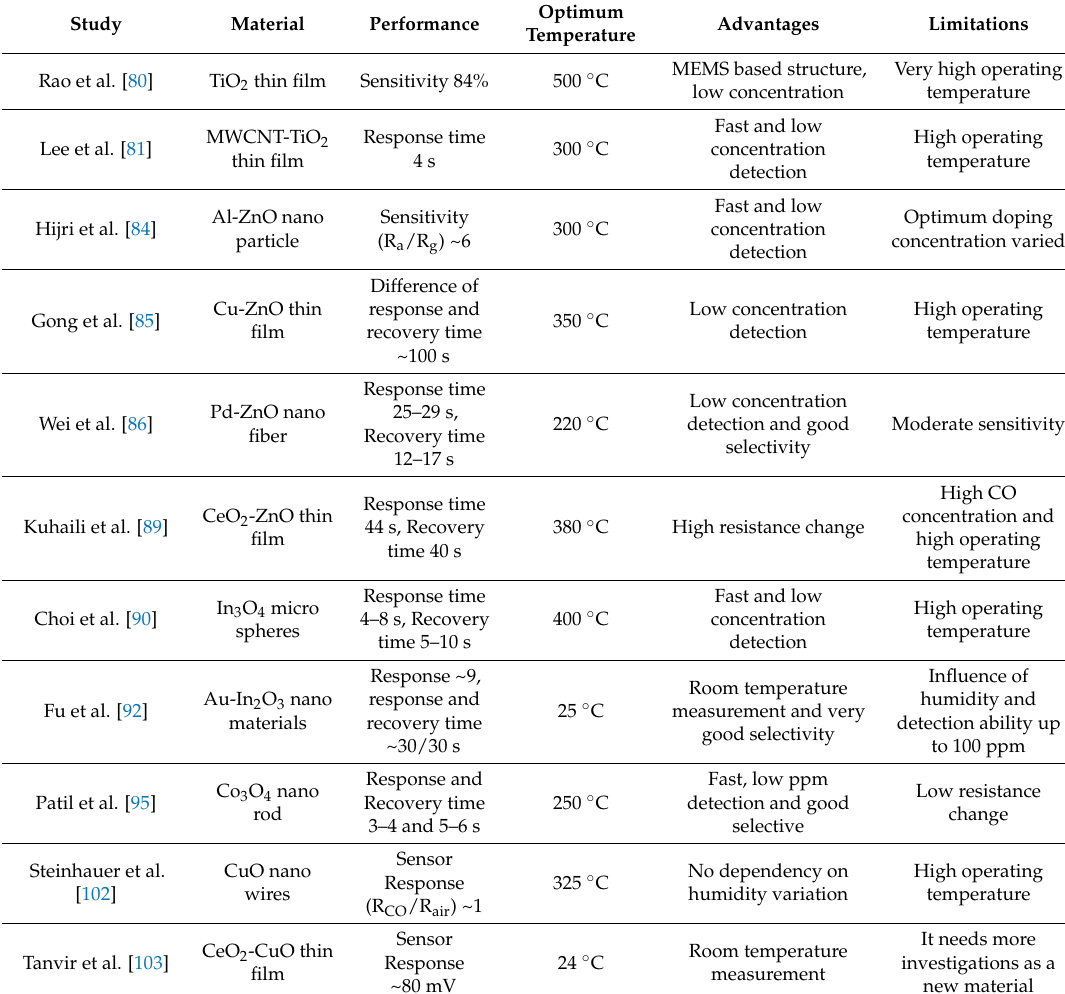
Table 3. Summary of the MOS materials for CO